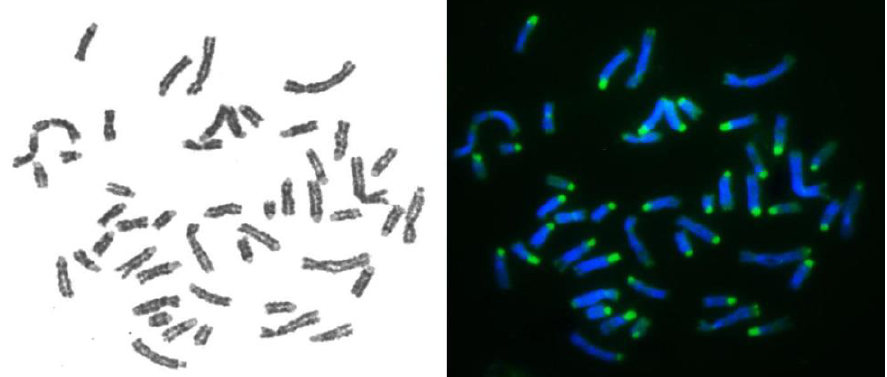
Figure 1. Comparative chromosome painting map of musk ox with homologies to human (HSA) and dromedary (CDR). Nucleolar organizing regions (NOR) show the localization of the nucleolar organizing region.